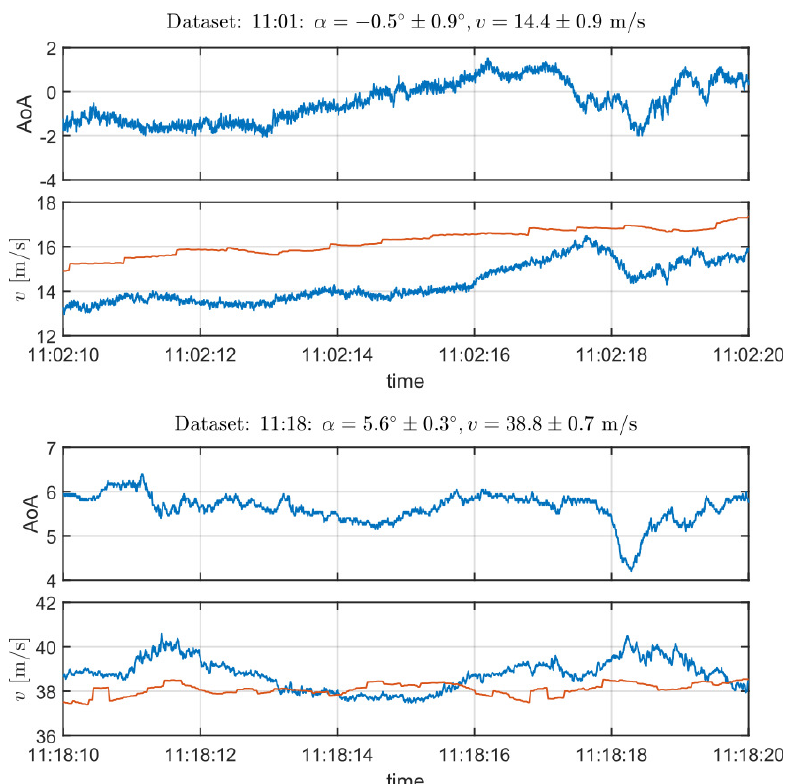
Figure 11. Inflow properties of different operation states. ( Top ) Start-up (SU); ( Bottom ) steady state (SS). Shown are AOA ( Upper row ) and inflow velocity ( Lower row ). ( Blue ) Velocity obtained by five-hole probe; ( Red ) velocity obtained by SCADA